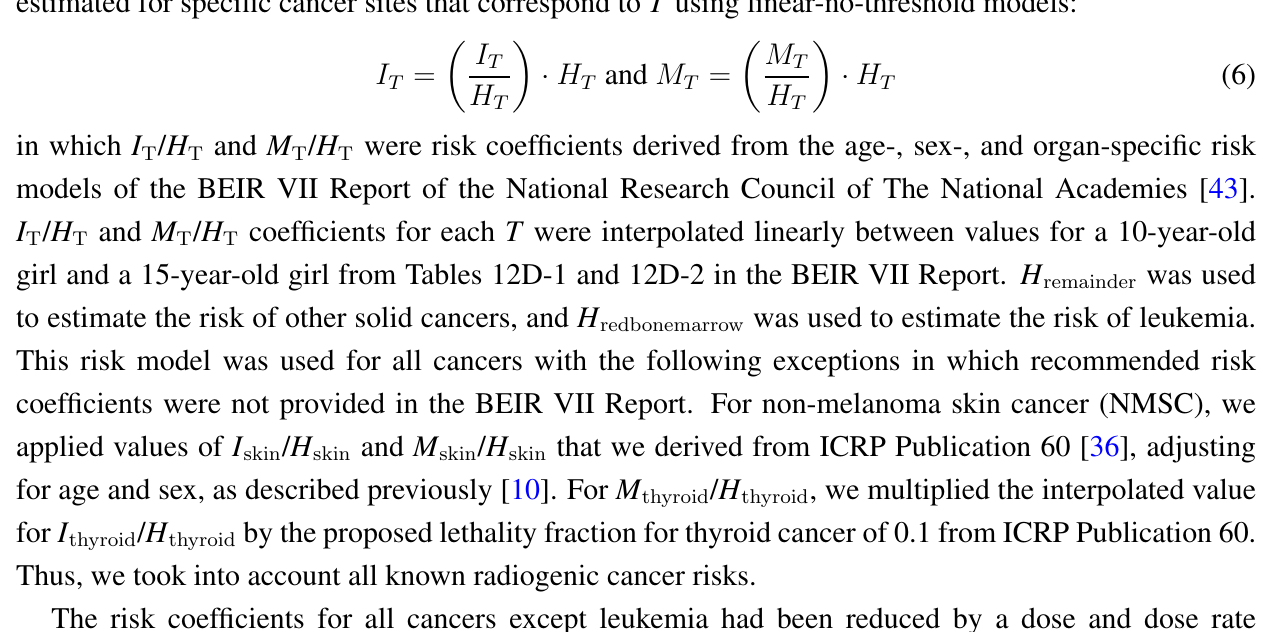
Table 3. Risk coefficients for radiogenic cancer incidence, I